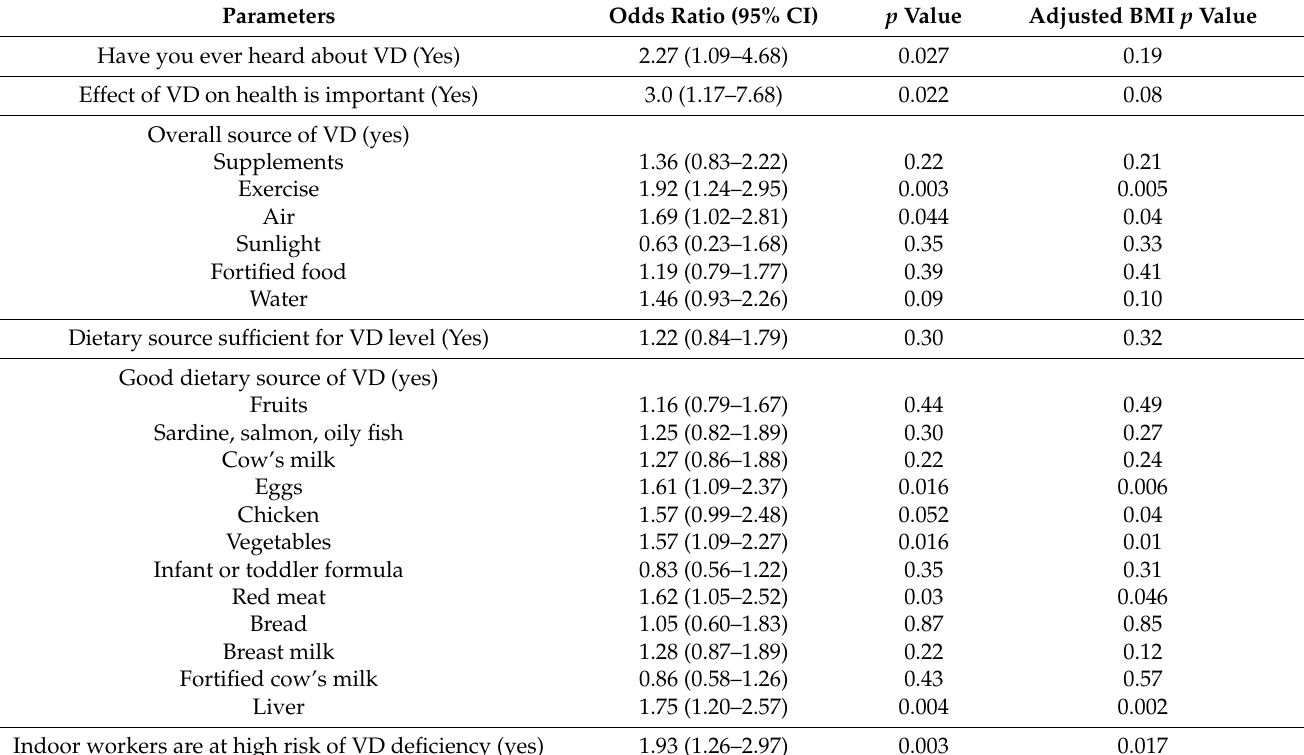
Table 4. Logistic regression analysis for PA with other parameters (negative response as the